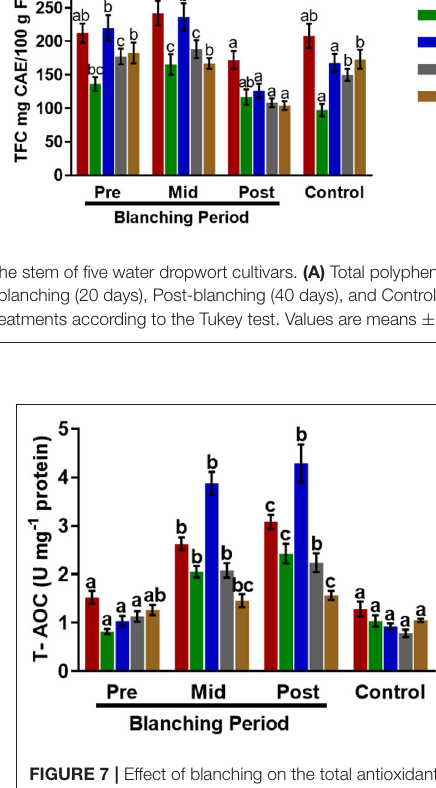
FIGURE 6 | Effect of blanching on the DPPH (2,2-diphenyl-1-picryl-hydrazyl-hydrate) activity in the stem of five water dropwort cultivars. Gallic acid was used as a standard. Four types of samples were analyzed; Pre-blanching, Mid-blanching (20 days), Post-blanching (40 days), and Control (grown under normal conditions). Different letters indicate a significant difference ( P < 0.05) among the treatments according to the Tukey test. Values are means ± SE.